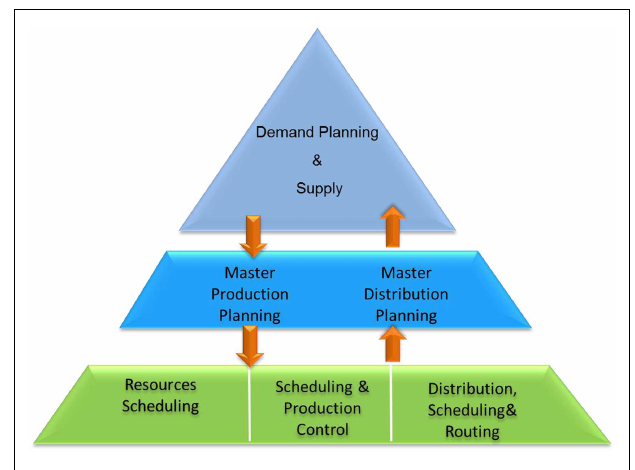
FIGURE 3 | Supply chain planning